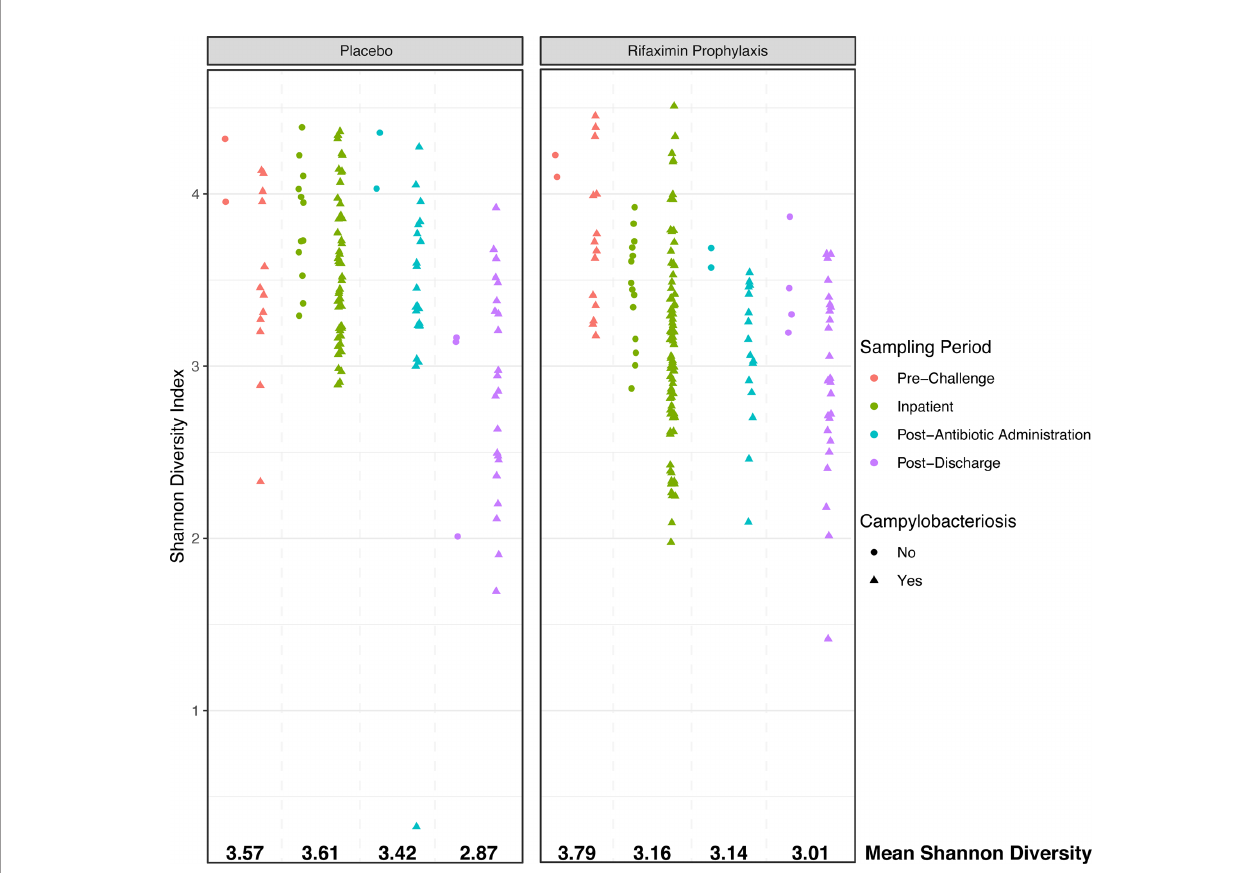
FIGURE 4 | Shannon alpha diversity plot comparing placebo- and rifaximin-treated study participants during each phase of the CHIM. Sample shape denotes samples from study participants who either developed campylobacteriosis (triangles) or did not